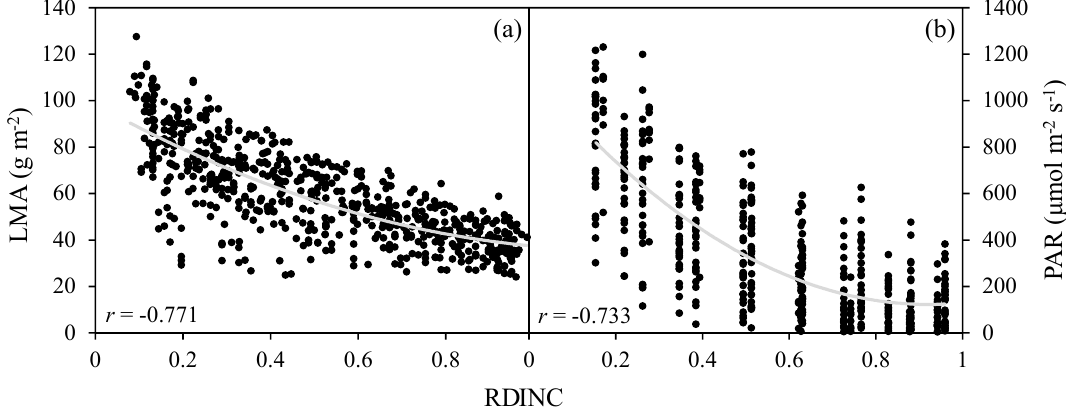
Figure 7. The relationships: ( a ) between leaf mass per area (LMA) and relative depth into the crown (RDINC) and ( b ) between photosynthetically active radiation (PAR) and RDINC. The r values are Spearman’s correlation coefficients. The solid gray line represents the fitting results based on polynomial equations.